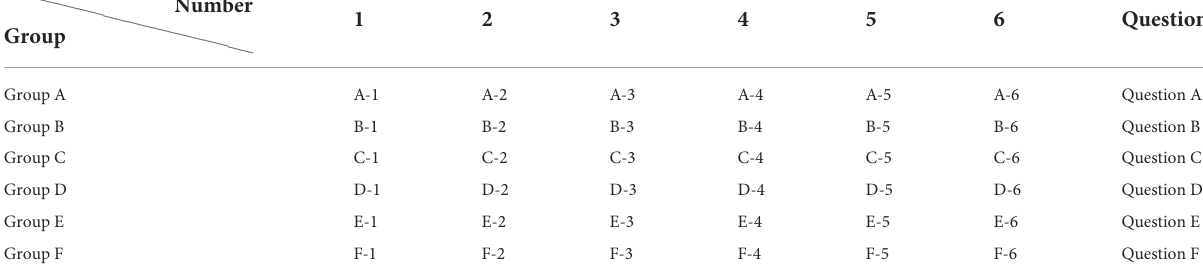
TABLE 1 Original subgroups of panel discussion in the experimental